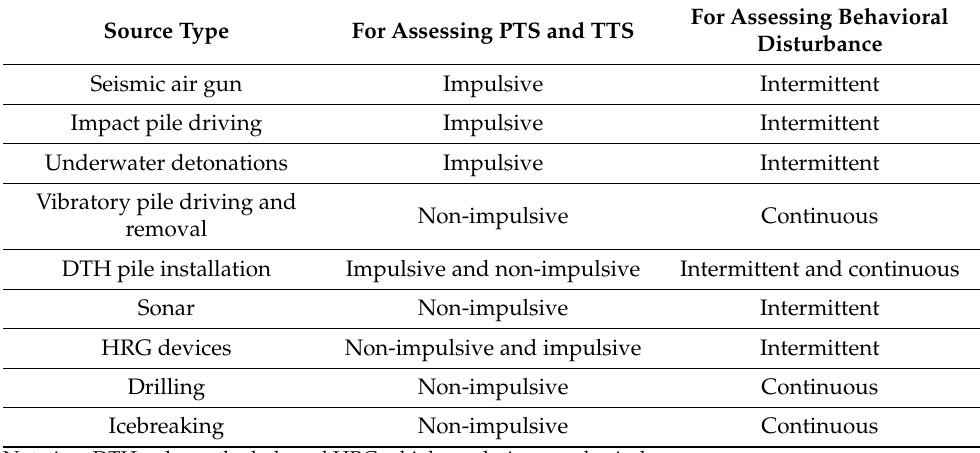
Table 2. Examples of common categories of sound sources regulated by the U.S. regulatory community. Source